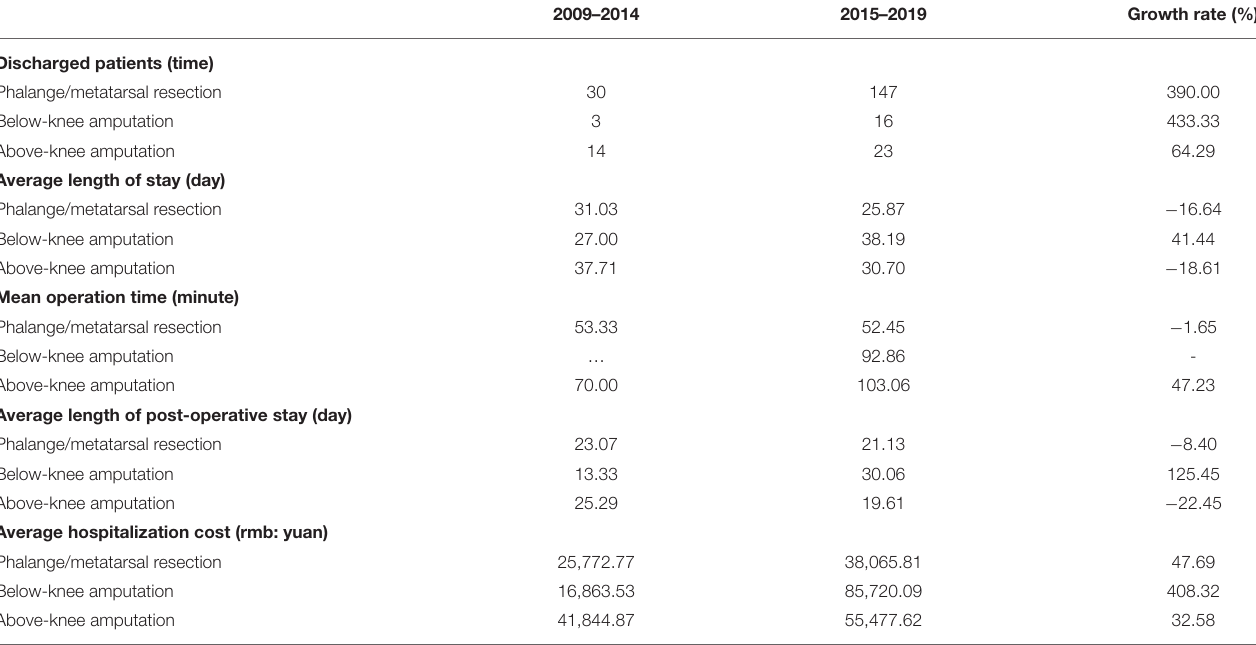
TABLE 7 | Comparison of indicators for phalange/metatarsal resection, below-knee amputation and above-knee amputation patients during 2009–2014 and